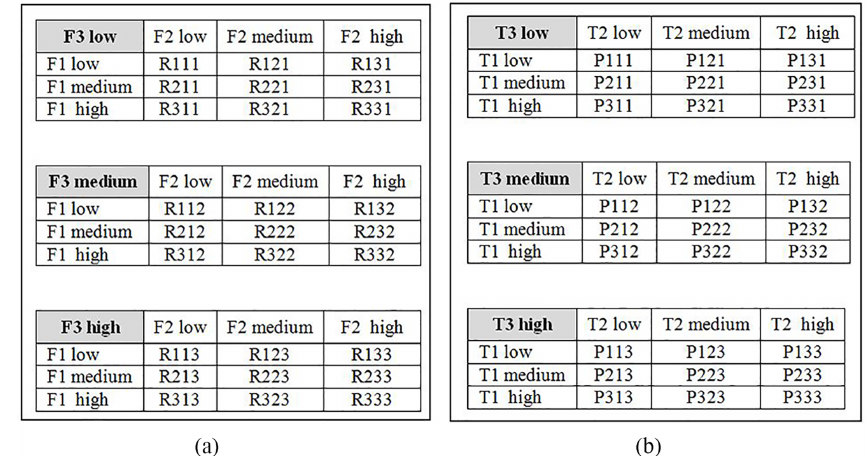
Figure 14. Fuzzy inputs and outputs (a) relations (b) Prepositions.